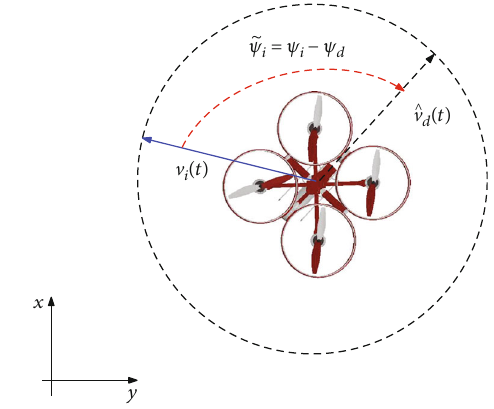
Figure 2: Planar projection of the quadrotor ’ s velocity and the desired velocity generated by the guidance